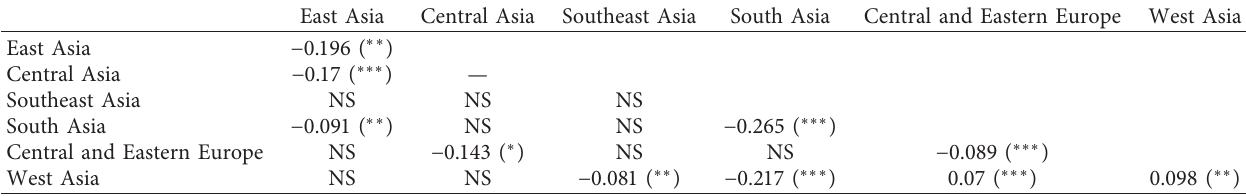
Table 5: Results of OLS regression analysis of the CD within and between subregions.